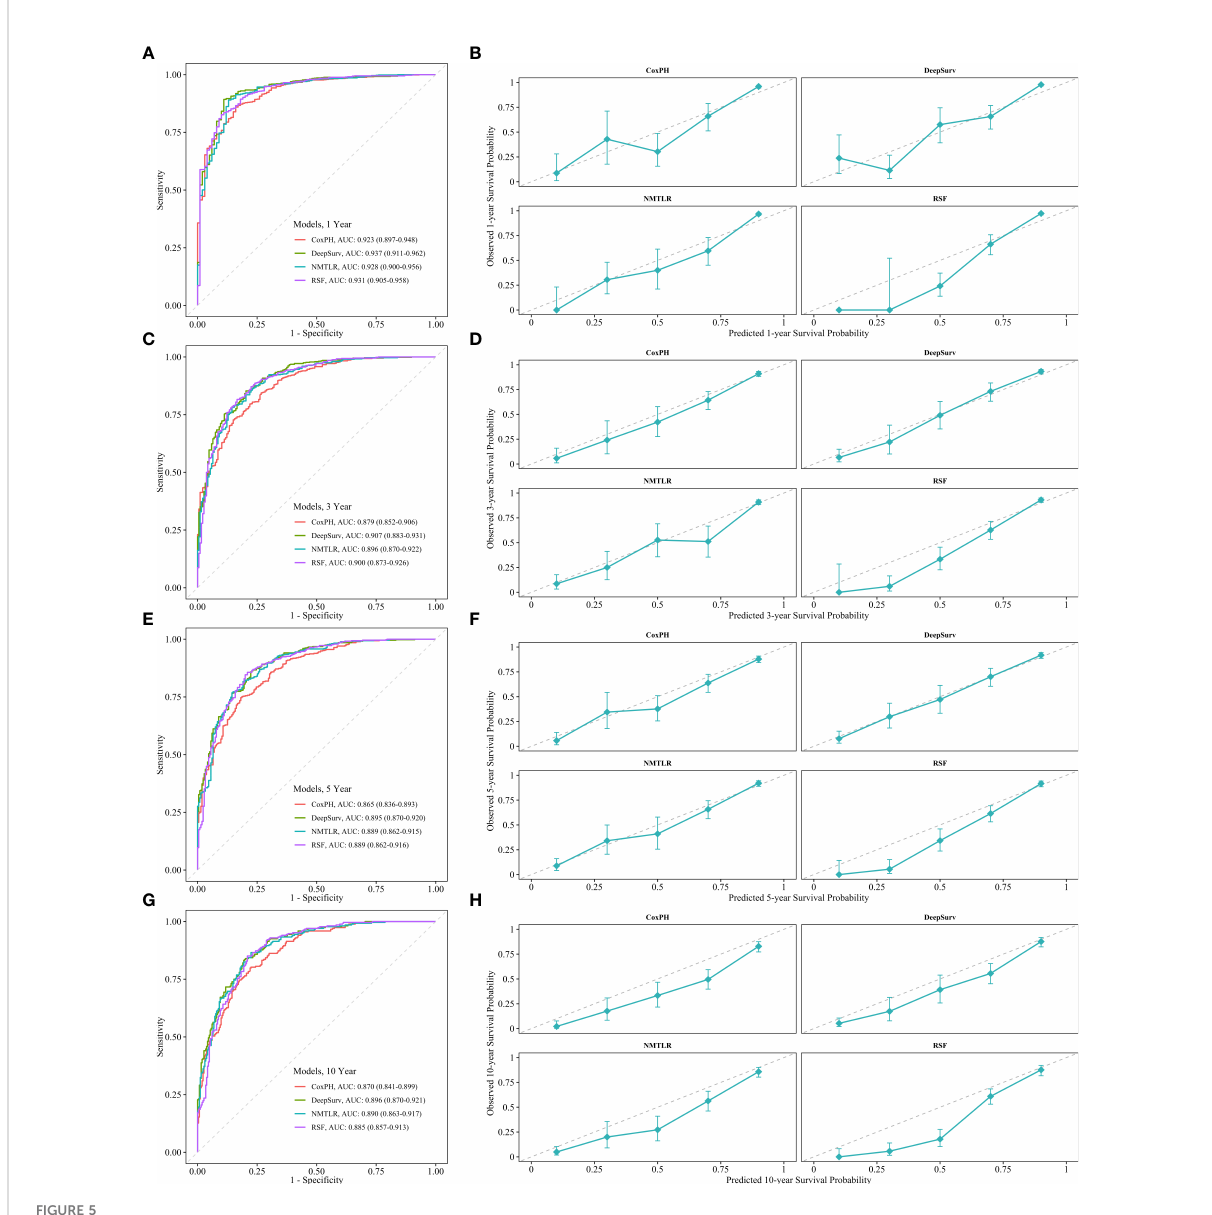
FIGURE 5 The receiver operating curves (ROC) and calibration curves for 1-, 3-, 5-, 10-year survival predictions. ROC curves for (A) 1-, (C) 3-, (E) 5-, (G) 10-year survival predictions. calibration curves for (B) 1-, (D) 3-, (F) 5-, (H) 10- year survival